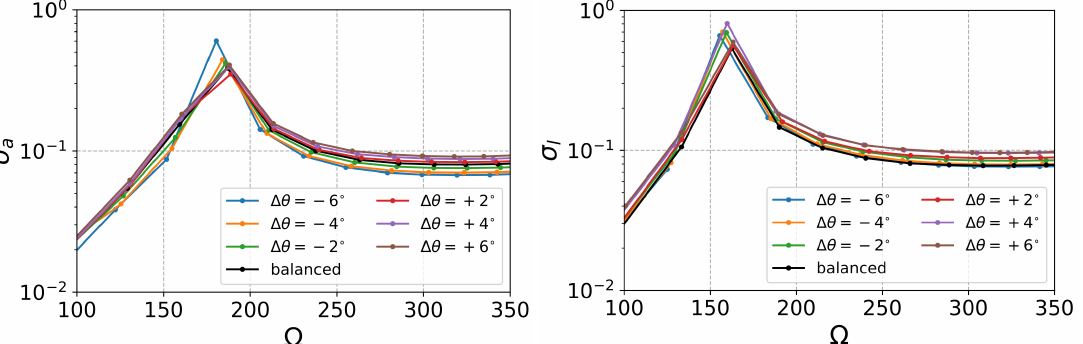
Figure 13. Standard deviations of the axial ( left ) and lateral ( right ) loads for θ = 2 ◦ .